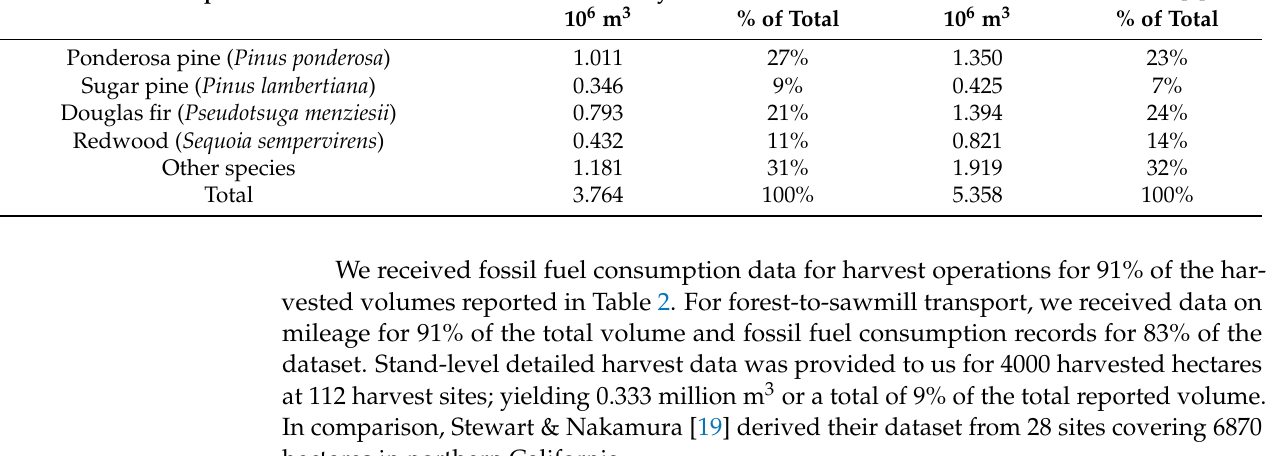
Table 2. Timber volumes processed-surveyed (2015) vs. total volume (2016) in California. Species Surveyed